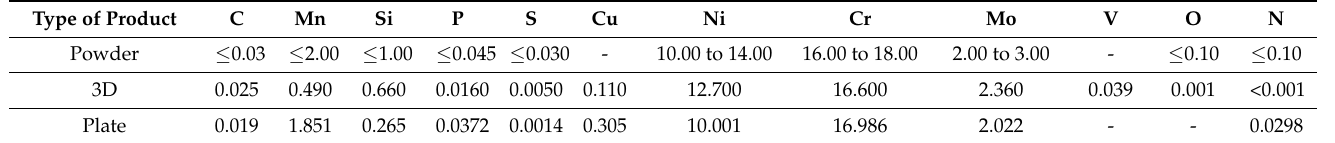
Table 1. Chemical composition of Powder SS 316L-0407, 3D-printed block and plate (wt.%).